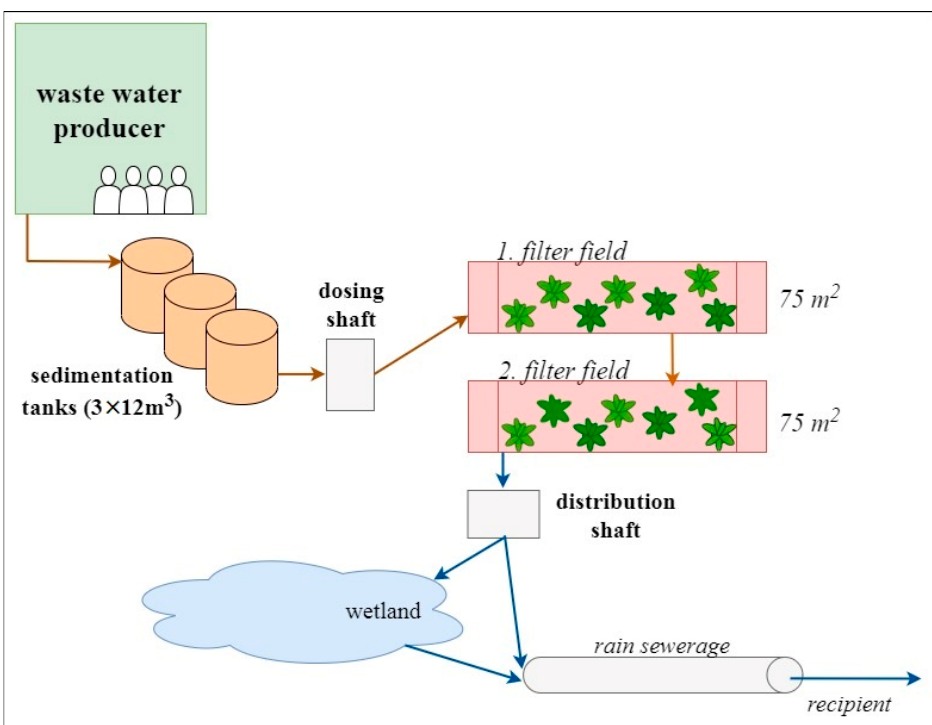
Figure 1. Scheme of a root WWTP type ECOver (according to the project documentation of ECOPLANET SLOVAKIA, s.r.o.; [19]).